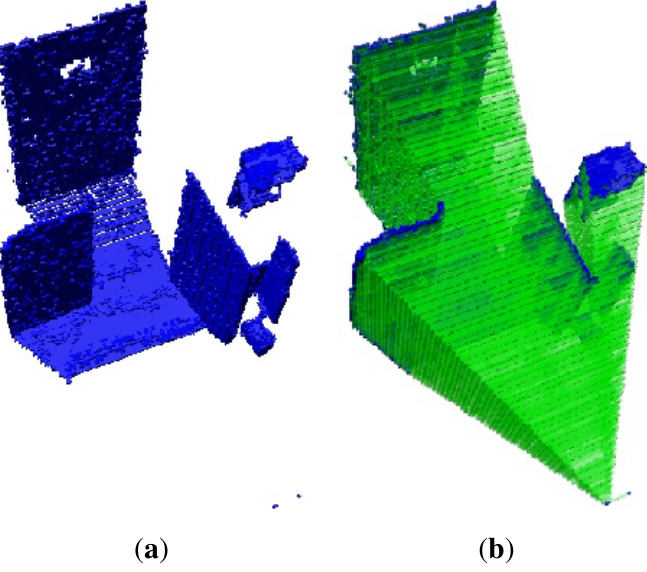
Figure 5. ( a ) First data occupied set volumes of the environment; ( b ) First data empty set volumes of the